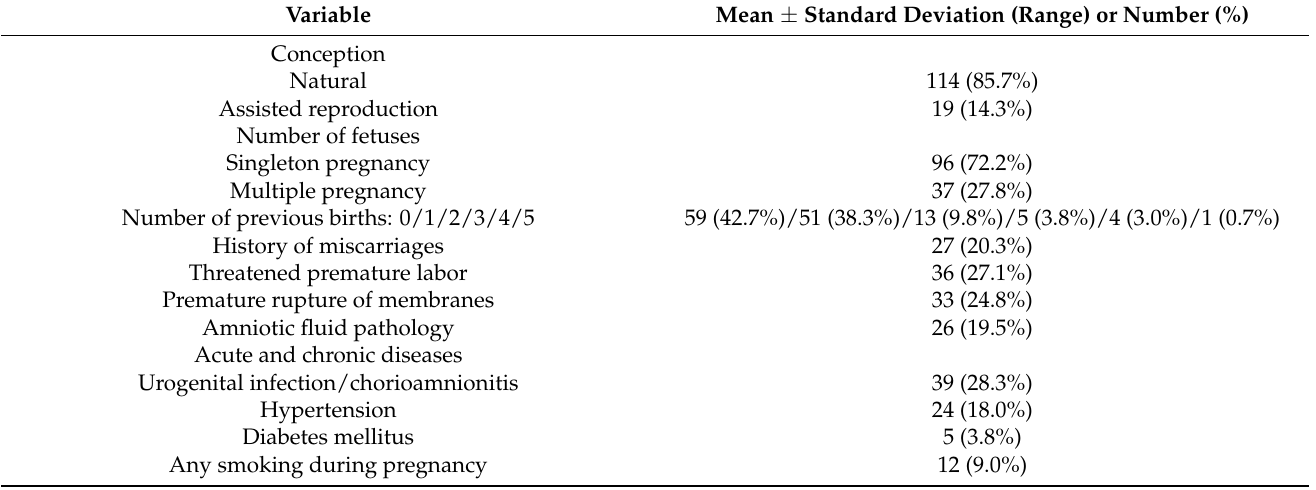
Table 1. The basic clinical characteristics of the pregnant